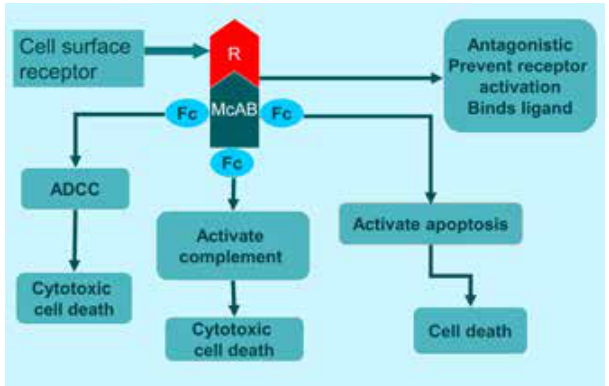
Figure 1. A summary of the consequences of monoclonal antibody binding to its specific receptor molecules. R: antibody specific receptor, McAB: monoclonal antibody, Fc: receptor binding to constant region of a monoclonal antibody, ADCC: antibody dependent cellular cytotoxicity